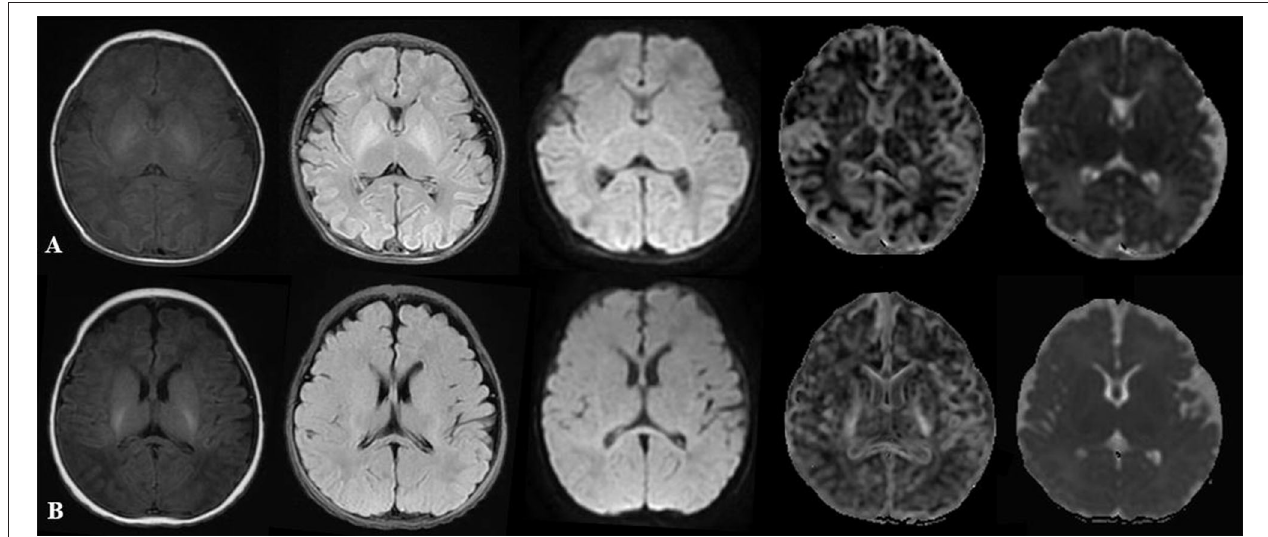
FIGURE 1 | Comparison of multiparameter images in different PMAs. (A) represented: male, GA 30 weeks, PMA 42 weeks. (B) represented: male, GA 37 weeks, PMA 43 weeks. From left to right: T1WI flair, T2WI flair, DWI, MK, and MD maps. DWI, diffusion-weighted imaging; PMA, postmenstrual age; GA, gestational age; MK, mean kurtosis; MD, mean